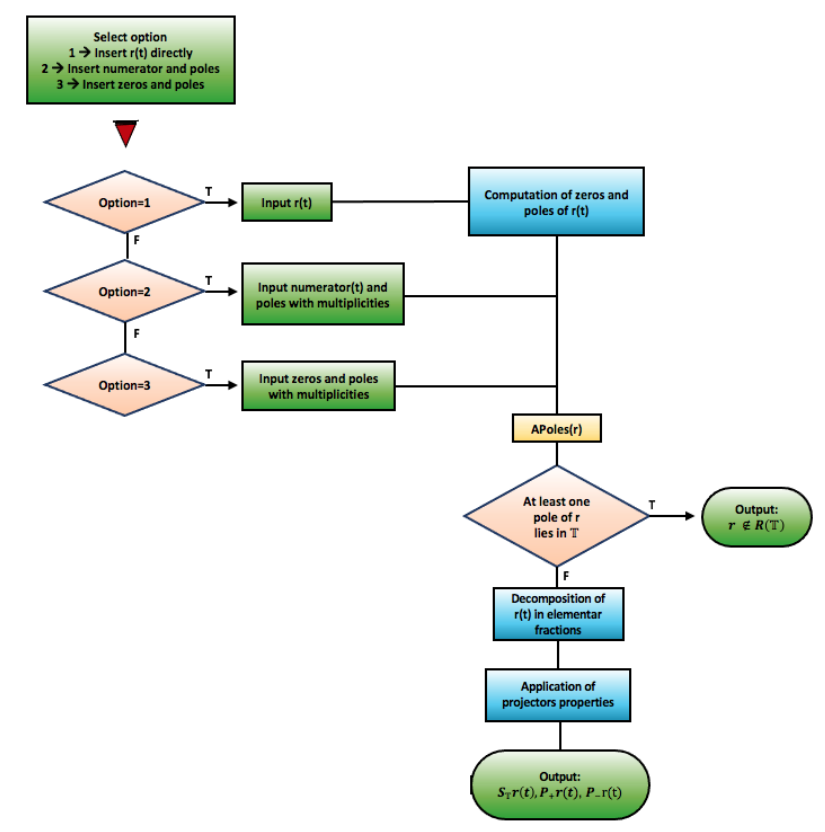
Figure 46. Flowchart of the [ASPPlusPMinus] algorithm. The algorithm allows three input options for the rational function r ( t ) (Figure